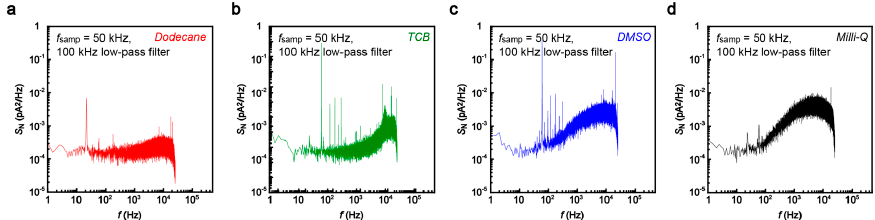
Figure 3. ( a – d ), Noise spectra obtained from the current versus time curves recorded at 50 kHz with a 100 kHz low-pass filter using an Au electrode gap of a size larger than 1 nm in dodecane ( a ); 1,2,4-trichrolobenzene ( b ); dimethyl sulfoxide ( c ); and Milli-Q ( d